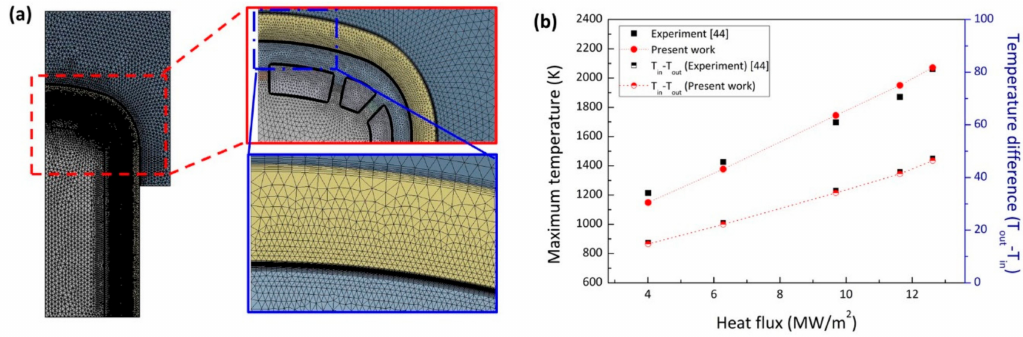
Figure 2. ( a ) Picture of generated mesh and inflation layer for the study and ( b ) graph of validation between the simulation and reported experimental